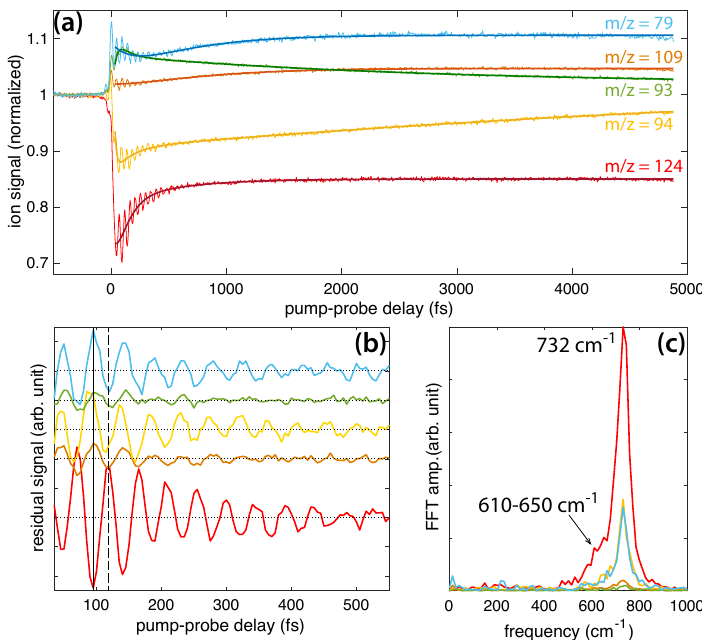
( a ) Transient signals of DMMP · + ( m / z = 124, red), PO 3 (CH 3 ) 3+ ( m / z = 109, orange), PO 2 C 2 H 7+ ( m / z = 94, gold), PO 2 (CH 3 ) 2+ ( m / z = 93, green), and PO 2 CH 4+ ( m / z = 79, blue). The dark solid lines denote fits to Equation (1). ( b ) Residual ion signals after exponential dynamics are subtracted. Dotted horizontal lines denote zero residual for each signal. Solid and dashed vertical lines denote the first minimum and maximum of the parent ion yield, respectively. ( c ) FFT of residual ion signals in ( b